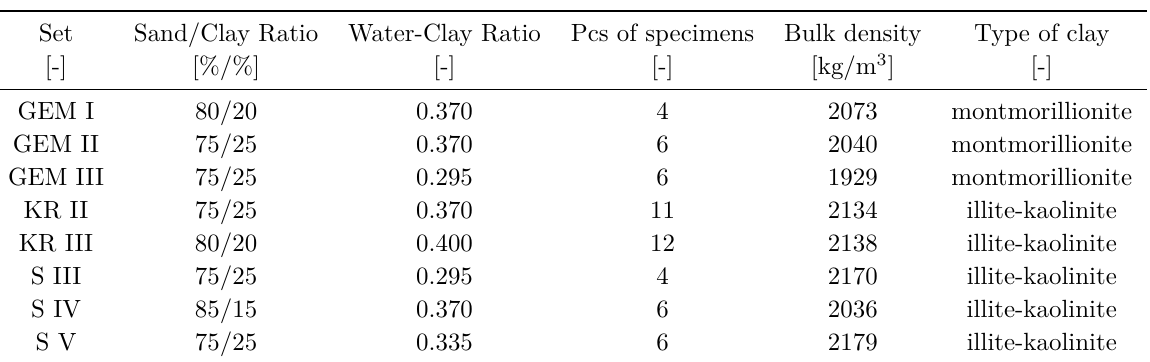
Table 1. Composition of used mixtures.